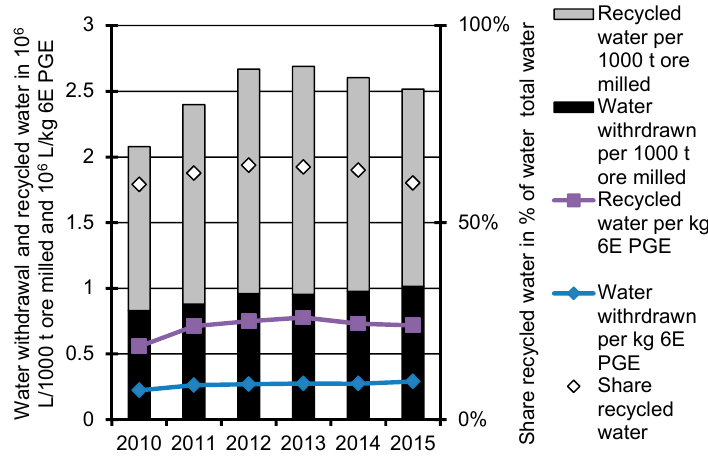
Figure 11. Water withdrawal, recycling in million L per 1000 t ore milled, per kg 6E PGE ( left axis ) and share of recycled water ( right axis ). Based on data from [58,59,62,63,68,69,71–73,79–84,89].